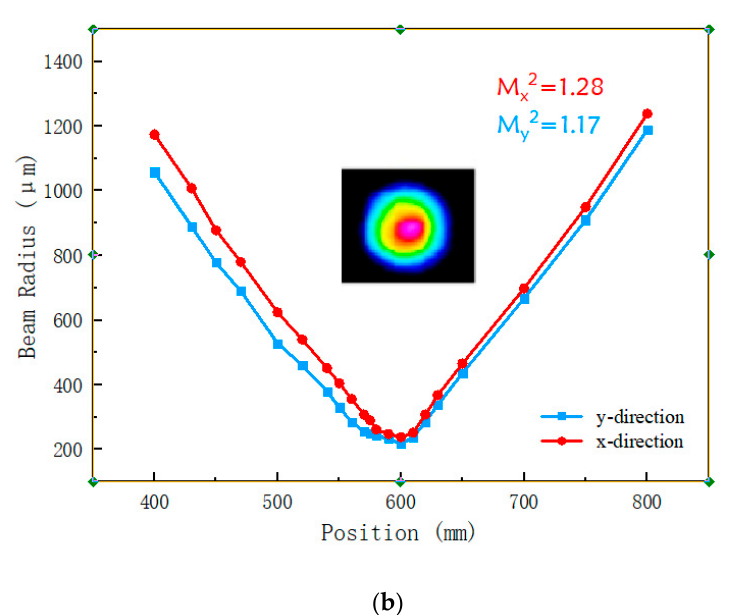
Figure 4. ( a ) Measured autocorrelation trace for the amplified pulse; ( b ) measured beam radius and fitted beam quality for the tangential direction ( ω x ) and the sagittal direction ( ω y )